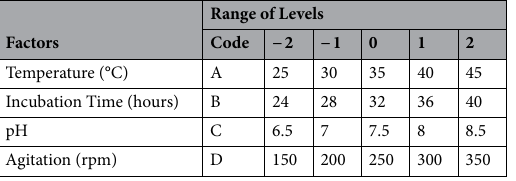
The PBD’s significant variables were fed into the CCD Software Design Expert, a popular quadratic test design for sequential test development that uses regression analysis to forecast component levels for optimal response. Temperature, pH, incubation period, and agitation were investigated at five different levels (−2, −1, 0, 1, 2) to see how they affected the cell concentration of the strain CW-S (Table 7). A total of 30 experiments were built using a full factorial central composite design with 16 (2 4 ) cube points, 6 center points, and 8 (4 × 2) star points. The relationship between cell concentration and independent factors was characterized using a quadratic model based on the second-order polynomial Eq. (5) 64 . Where Y is the measured response (cell concentration), X 1 and X 2 are significant independent variables, β 12 is the interactive regression coefficient, and β 0 is a constant term, and β 1 and β 2 are the linear regression coefficients,